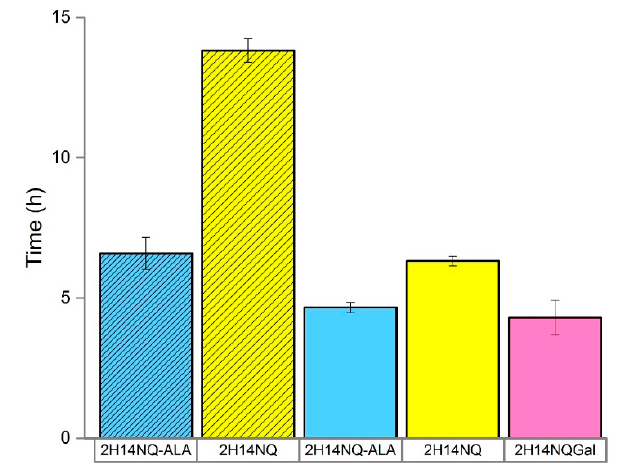
Figure 4. Detec tion time (h) for two E. coli strains; SHSP18 (shaded) and DSMZ-1576 (unshaded) in the presence and absence of ALA. Error bars represent the range of detection time between replicates (n = 2–3).